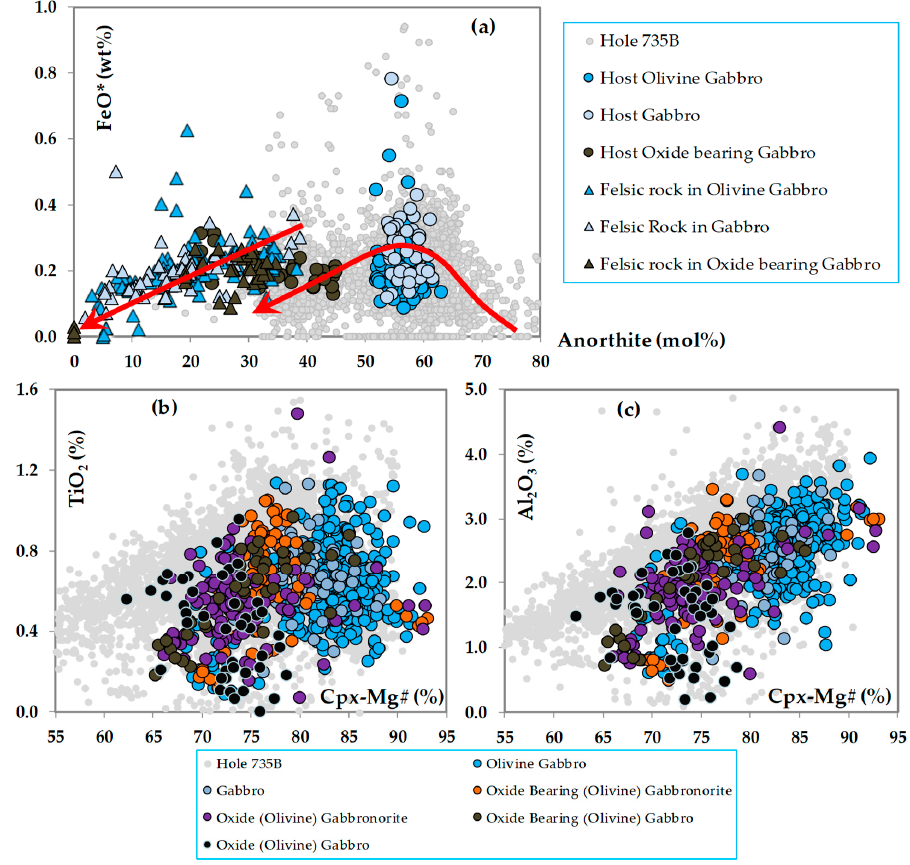
Figure 19. Preliminary geochemical comparison between IODP Hole U1473A and ODP Hole 735B, with data of ODP-Hole 735B taken from Reference [42]. ( a ) Plagioclase anorthite (mol%) versus FeO* (total iron oxide wt%). ( b , c ) Clinopyroxene Mg# (mol%) plotted versus TiO 2 and Al 2 O 3 , respectively;